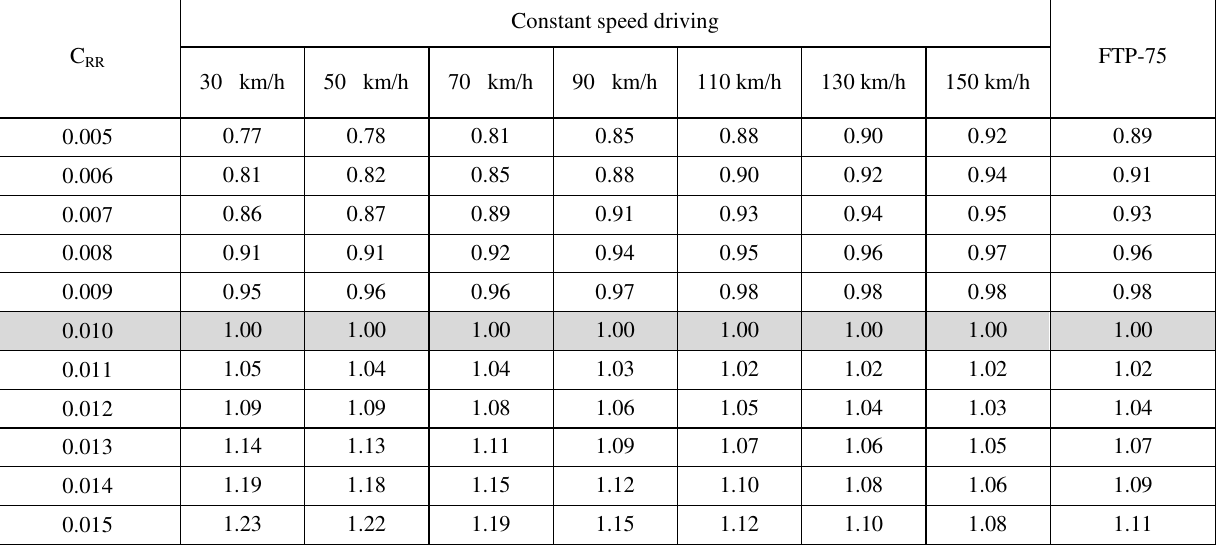
Table 3. Relative changes of energy consumption for conventional vehicles